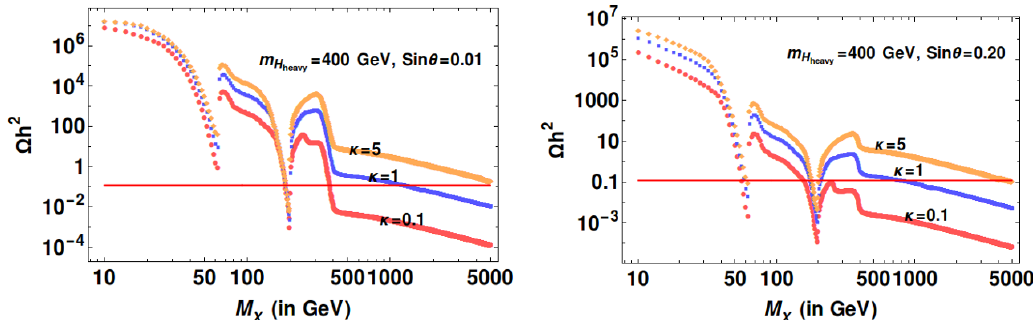
Figure 17 . Relic density vs DM mass for various (cid:20) (= (cid:21) 1 =(cid:21) 2 ) values in the high mass region. Here, orange, blue and red dotted lines stands for (cid:20) = 5, (cid:20) = 1 and (cid:20) = 0 : 1